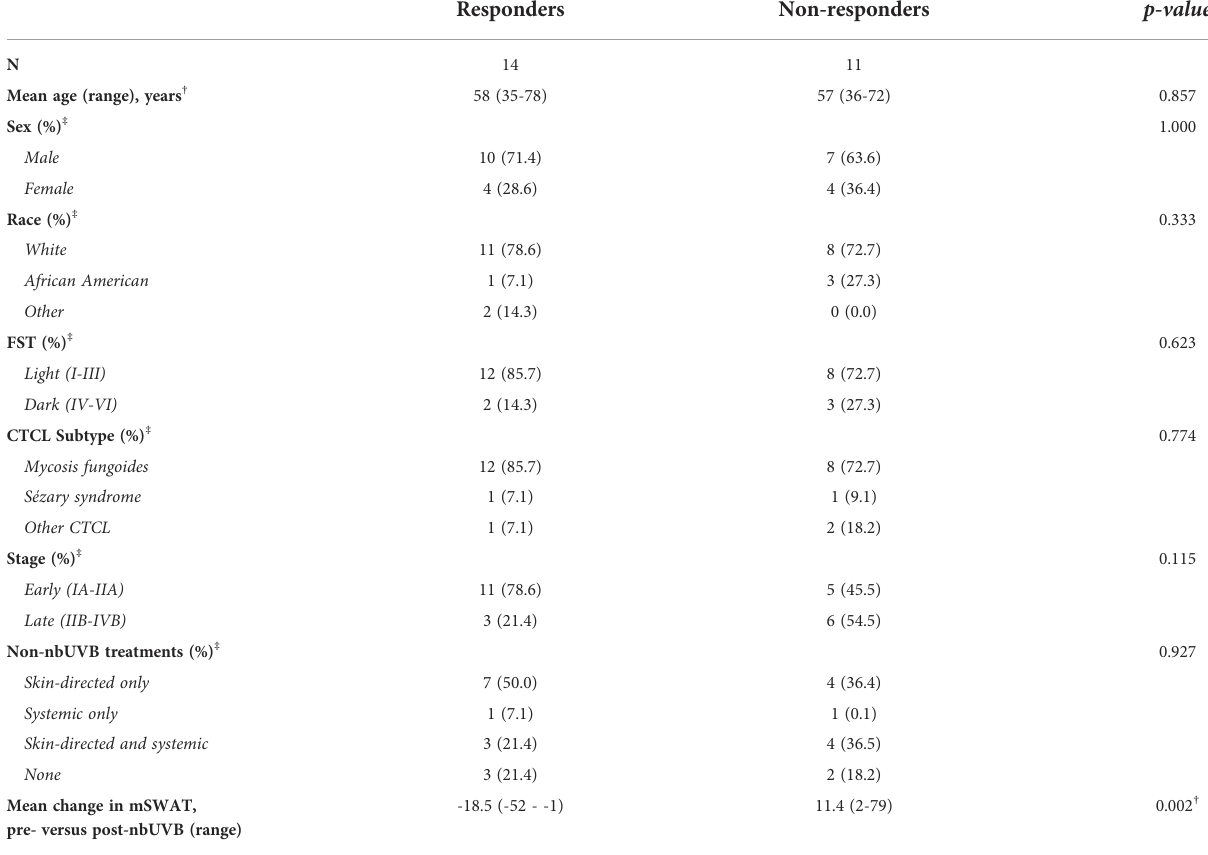
TABLE 1 Patient demographic and clinical